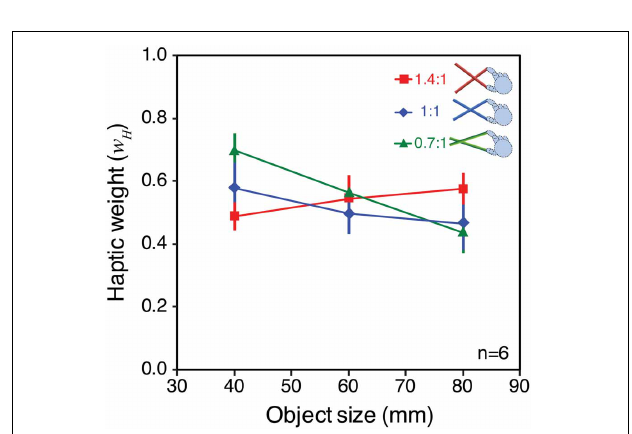
FIGURE 8 | Observed signal weights in Experiment 2. The figure plots haptic signal weight for each “base” object size, and tool type, averaged across all participants. The weights were calculated from the effect of varying visual size in each case (the slopes of the lines in Figure 7 ), and assuming that w H = 1 − w V . See main text for details of this calculation. Error bars denote ± 1 standard